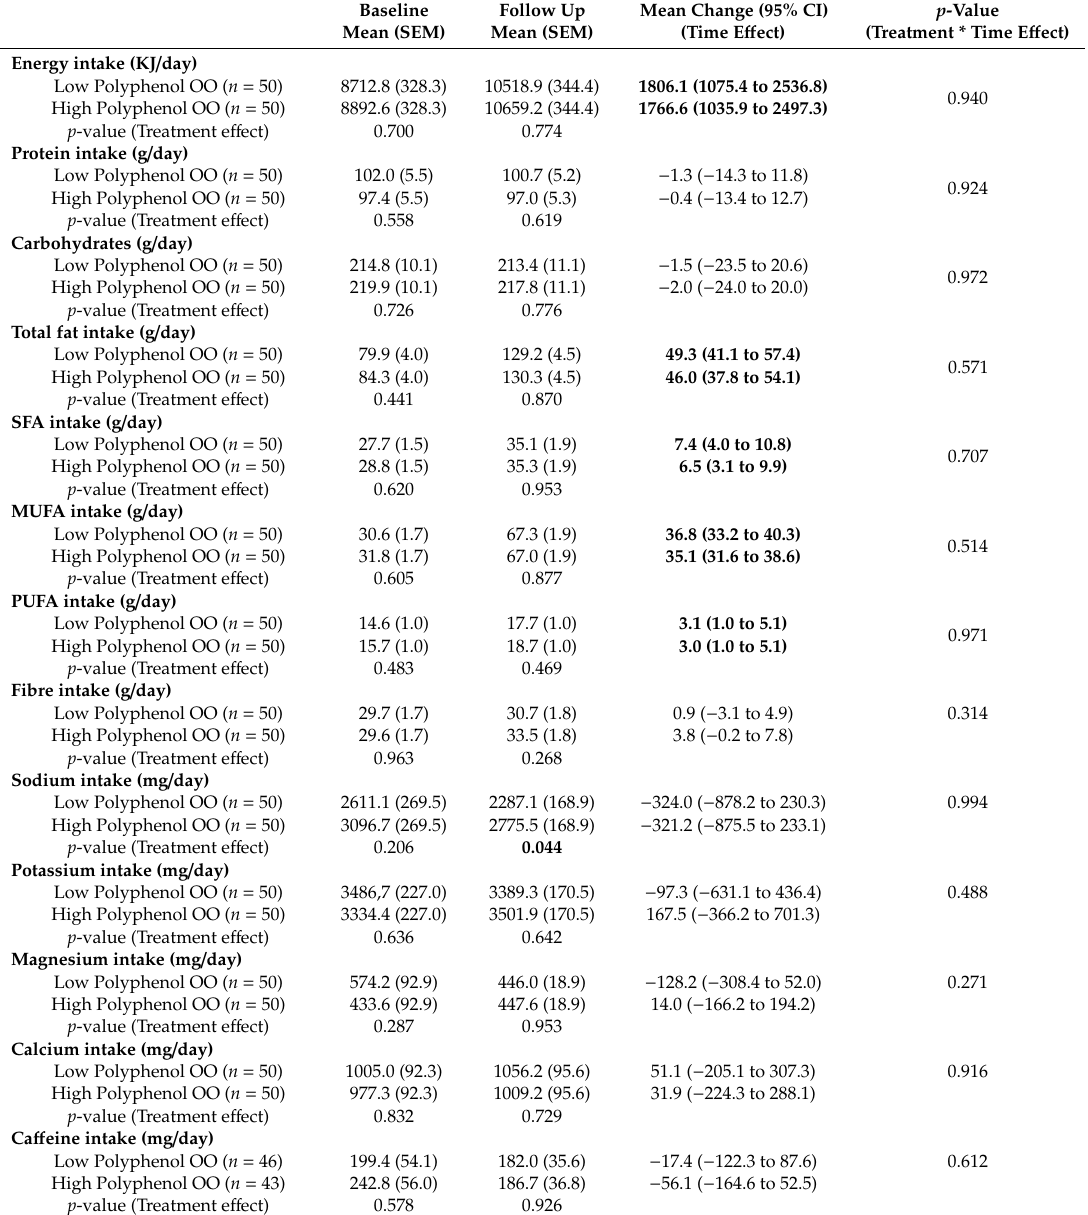
Table 2. E ff ect of low polyphenol OO vs. high polyphenol OO on mean changes in dietary energy, macro- and micronutrient